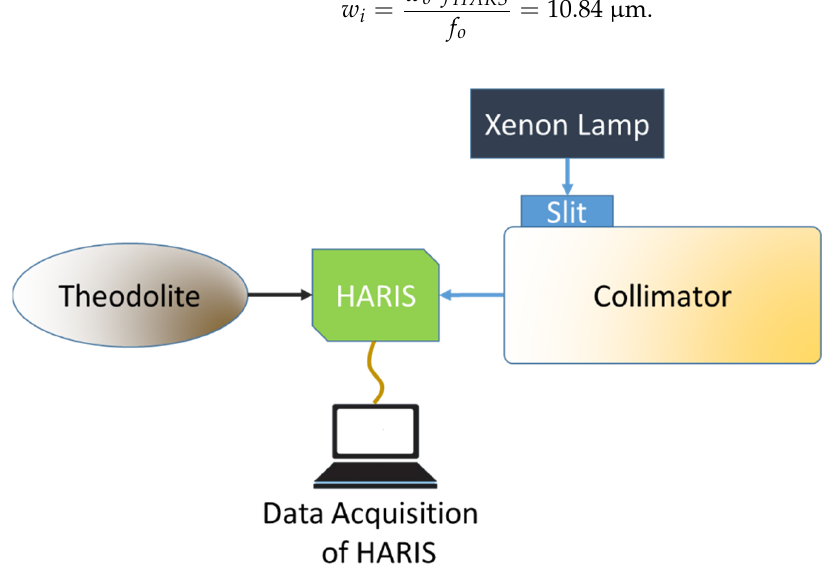
Figure 9. Diagram depicting the equipment for the geometric calibration of HARIS.